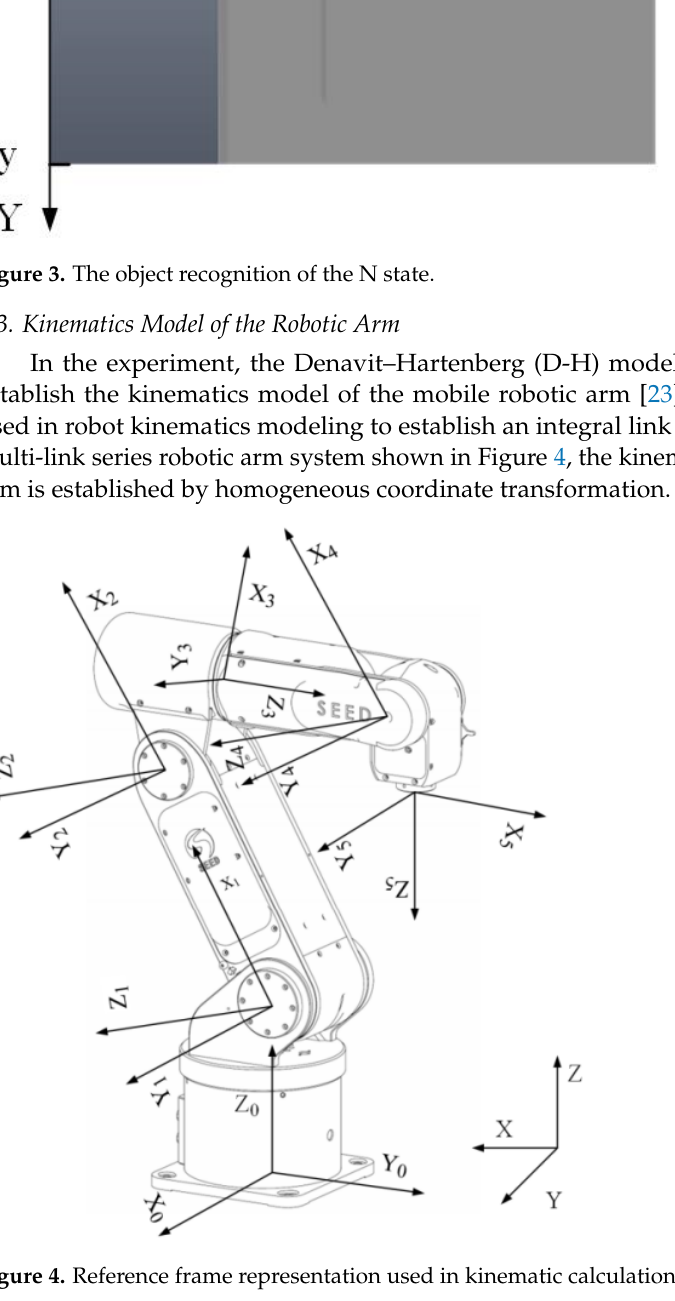
Figure 4. Reference frame representation used in kinematic calculations of the robotic arm.